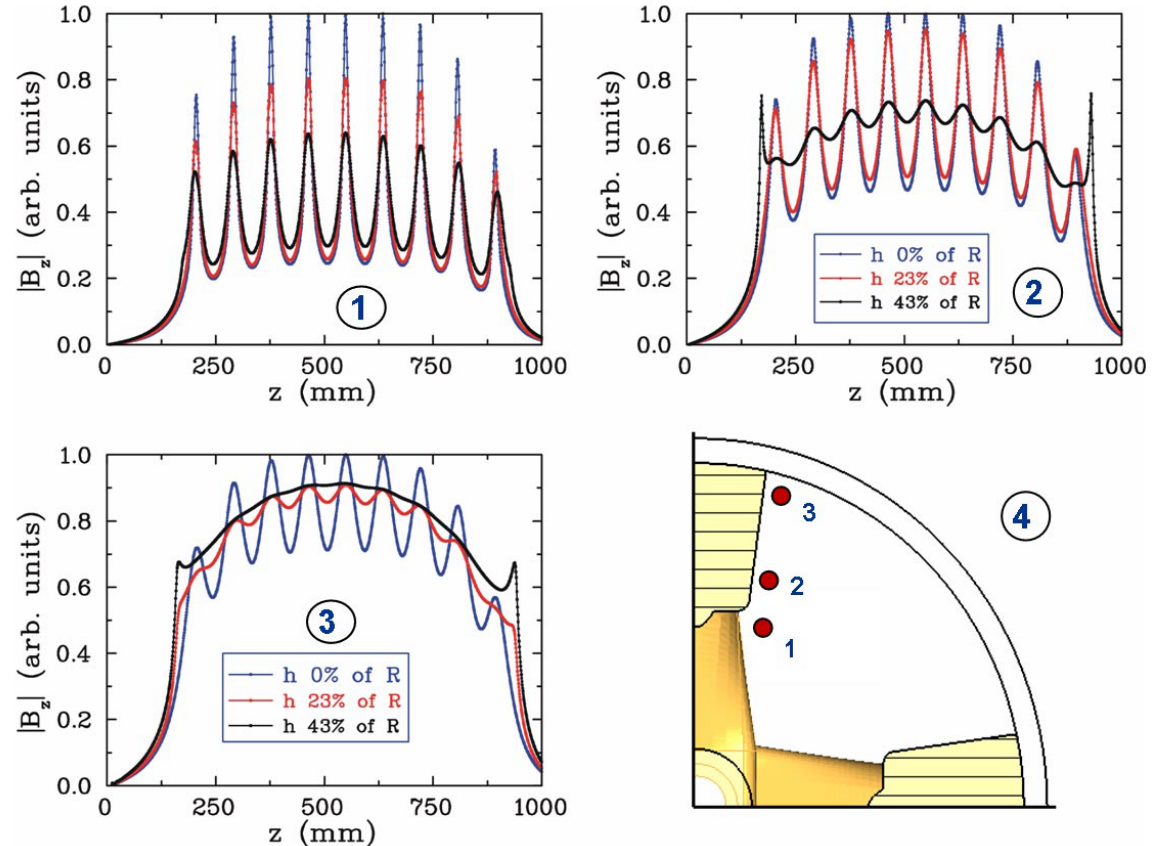
j along the CH cavity. The field is shown for three different paths along the cavity. The FIG. 8. (Color) Plot of the magnetic field j B z girders support a flat field distribution along a CH cavity and lead to very homogeneous local current densities which reduce the magnetic peak fields.